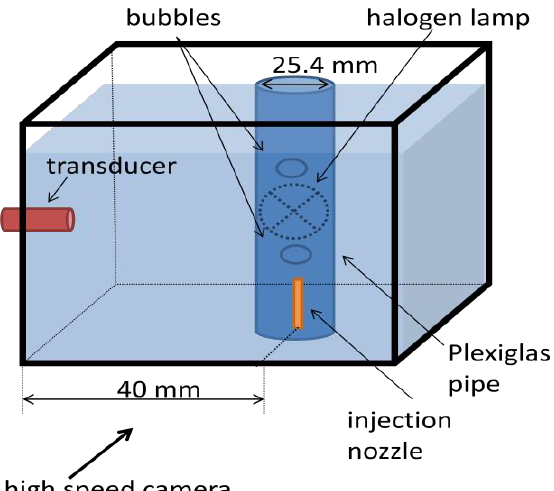
Figure 12. Experimental set-up for free-rising bubbles in quiescent liquid enclosed by a Plexiglas